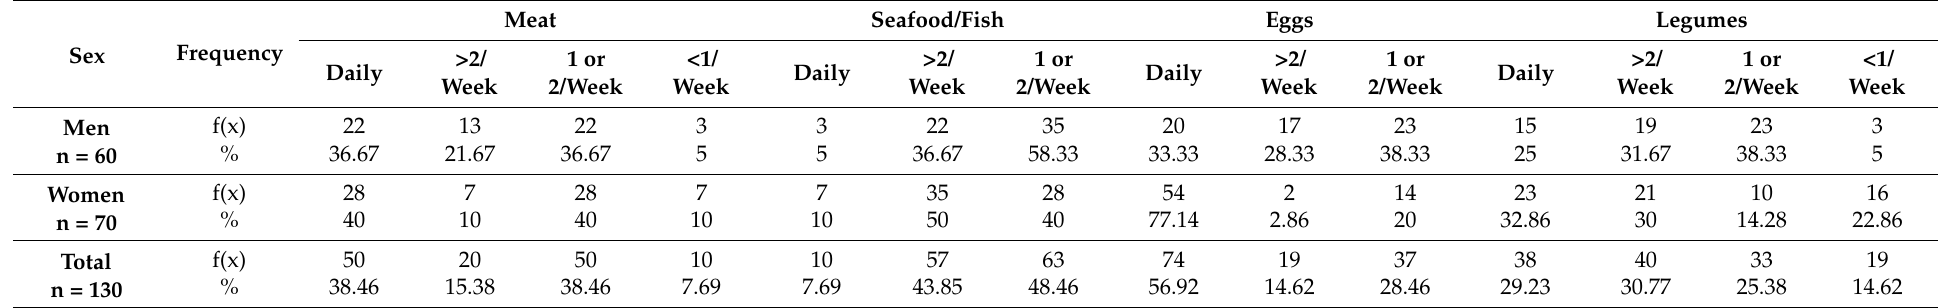
Table 4. Consumption frequency of food groups according to food intake. Classification in accordance with dietary recommendations for older adults. Weekly consumed